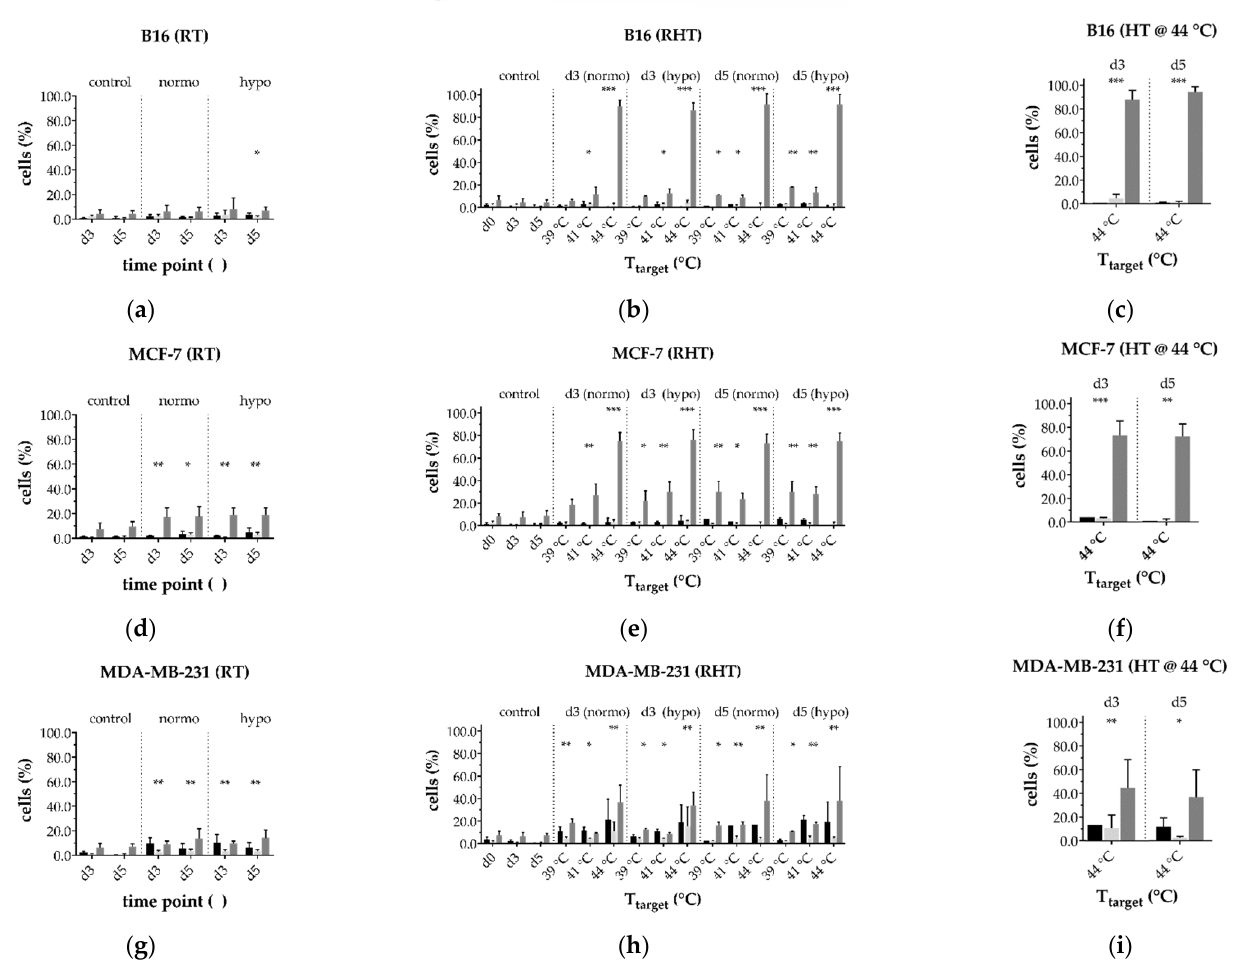
Figure 9. Cell death forms of ( a , b , c ) B16 melanoma; ( d , e , f ) MCF-7 breast cancer and ( g , h , i ) MDA-MB-231 breast cancer after radiotherapy (RT, left column) alone or in combination with normo- or hypofractionation radiotherapy (RHT) on day 3 (d3) and day 5 (d5) (middle column). The right column shows cell death forms for 915 MHz hyperthermia at 44 °C on d3 and d5. The total percentage of dead cells yields the tumor cell killing efficiency. Mean ± S.D. are presented from at least three independent experiments, each measured in duplicate. Significance was conducted using Kruskal-Wallis test with Dunn’s correction multiple comparison, by comparing treatment related total percentage of inactivated cells to the corresponding control of mock-treated cells at the indicated time point (d3, d5); * ( p < 0.1), ** ( p < 0.01), *** ( p < 0.001).